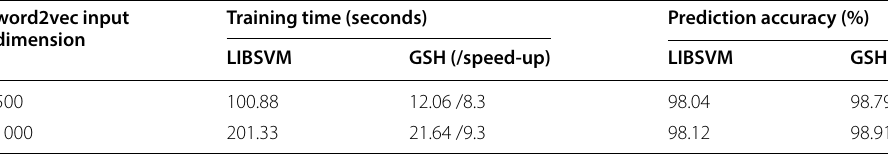
Table 12 Test parameters and